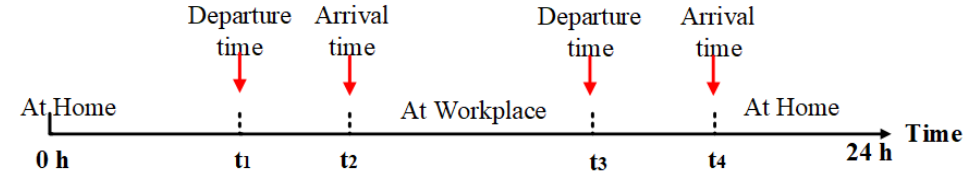
Figure 2. EV driving and plug-in times in a